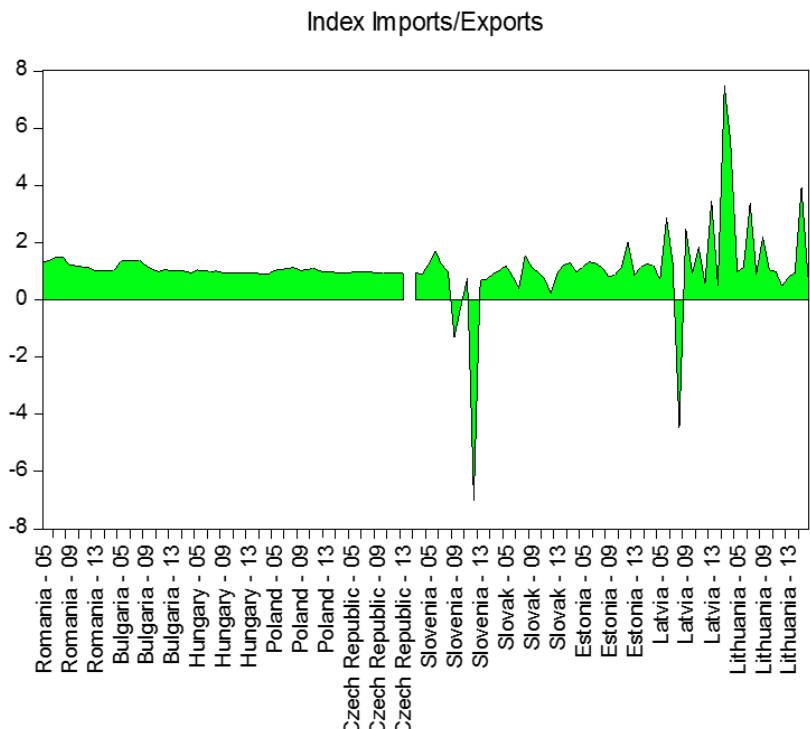
Figure 6. Evolution of the financial direct investment inflow (FDI_INF)/financial direct investment outflow (FDI_OUTF) index for the CEE countries.